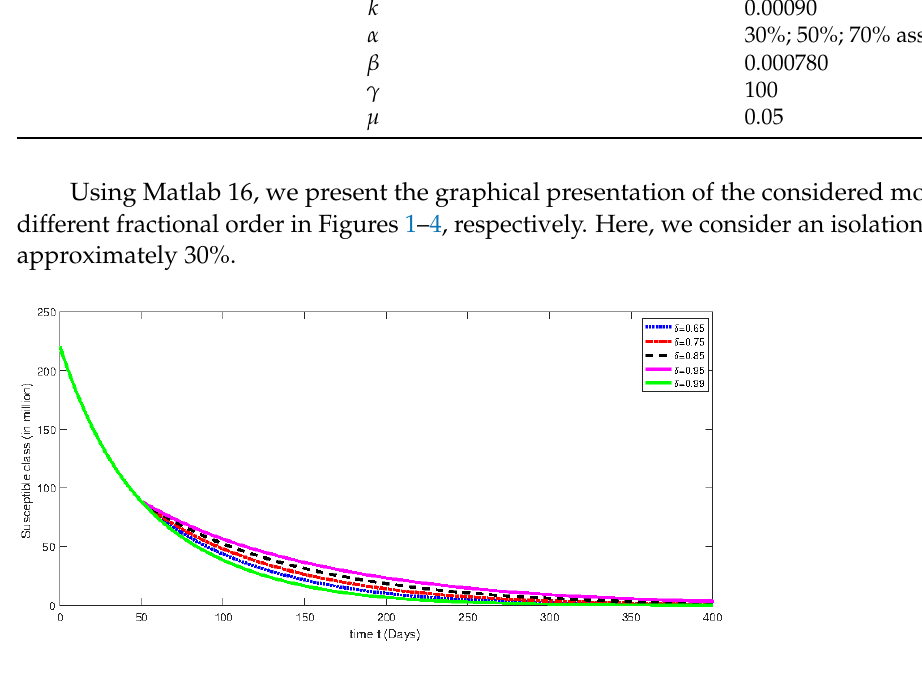
Figure 1. Numerical solution for susceptible class for the given days and using different fractional orders with isolation rate of